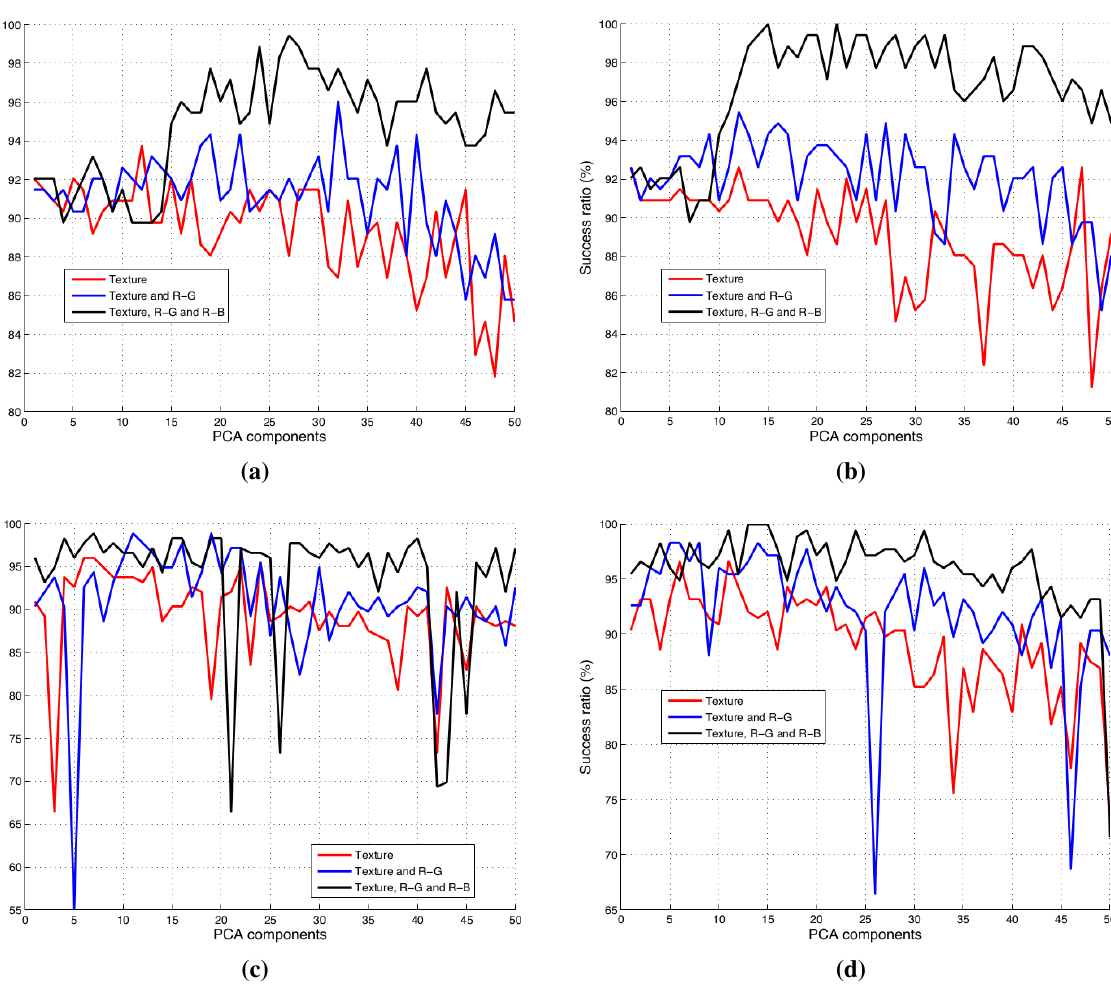
Figure 11. ( a ) Linear classification results without the ANOVA component filter; ( b ) linear classification results with the ANOVA component filter; ( c ) ANN classification results without the ANOVA component filter; ( d ) ANN classification results with the ANOVA component